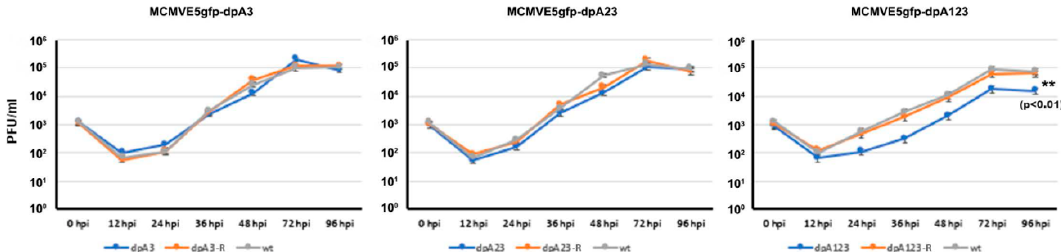
Figure 6. Viral growth curve by plaque formation unit (PFU) assay. The MCMVs (mutation, revertant, and wild-type) were infected onto NIH3T3 cells at an MOI of 0.01. The whole-cells and medium were collected at the indicated time postinfection. The samples were frozen and thawed for 3 cycles, and the supernatants were used for the PFU assay. Three independent experiments were performed, and the averaged PFU/mL numbers were used to create a viral growth curve. A t -test was used to compare the differences between the groups, ** p < 0.01.